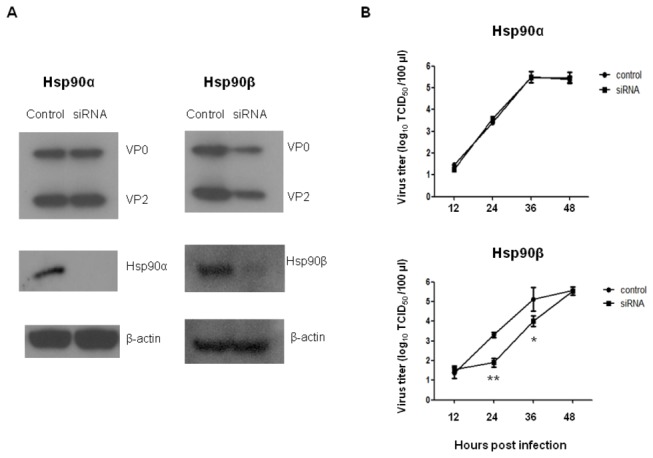
HSP90β but not HSP90α siRNA inhibits EV71 infection.RD cells were transfected individually with 200 pmoles of HSP90α, HSP90β, or the control siRNA, and then incubated for 24 hours, Cells were following infected with MOI=0.01 of EV71 5746 strain. Cells were washed after one hour of infection and cultured for another 16 hours. (A) Cells were lysed and detected the EV71 capsid proteins, HSP90α, and HSP90β by Western blot using specific antibodies, respectively. Cellular β-actin was detected by blotting the same membrane with monoclonal anti-β-actin antibody. (B) The culture mediums were harvested at 12, 24, 36, and 48 hours post infection and applied to detect virus titer (TCID50) as described in the Materials and Methods. Data represented one of two independent experiments. Unpaired student t test with Welch correction was calculated.